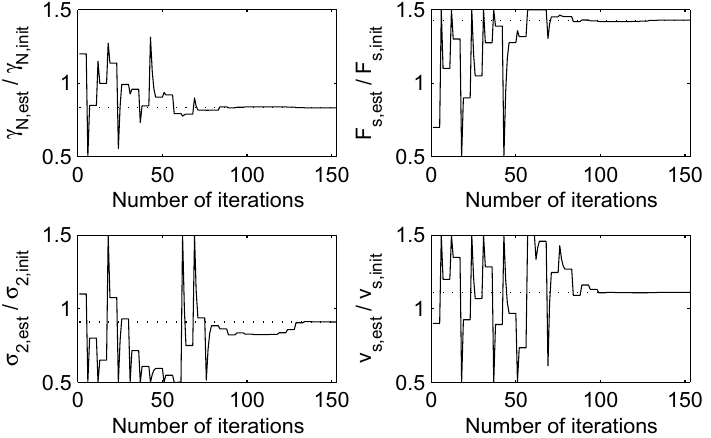
Fig. 4. Simulation of the identification of the LuGre friction model static parameters using the optimization-based algorithm ( −− ) and true parameter value ( ···· ).